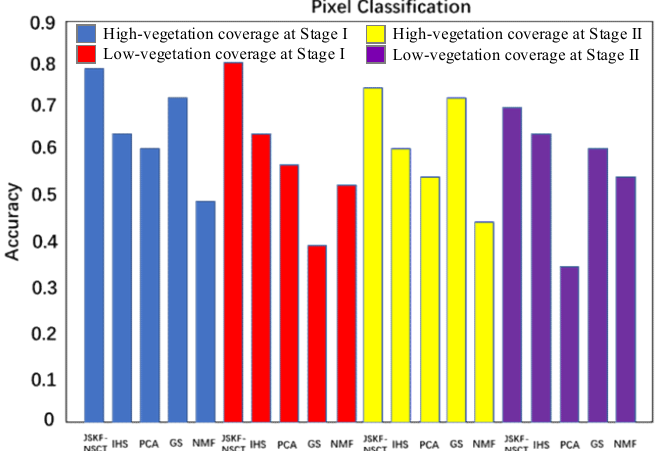
Figure 10. Pixel clustering accuracy using the five fusion